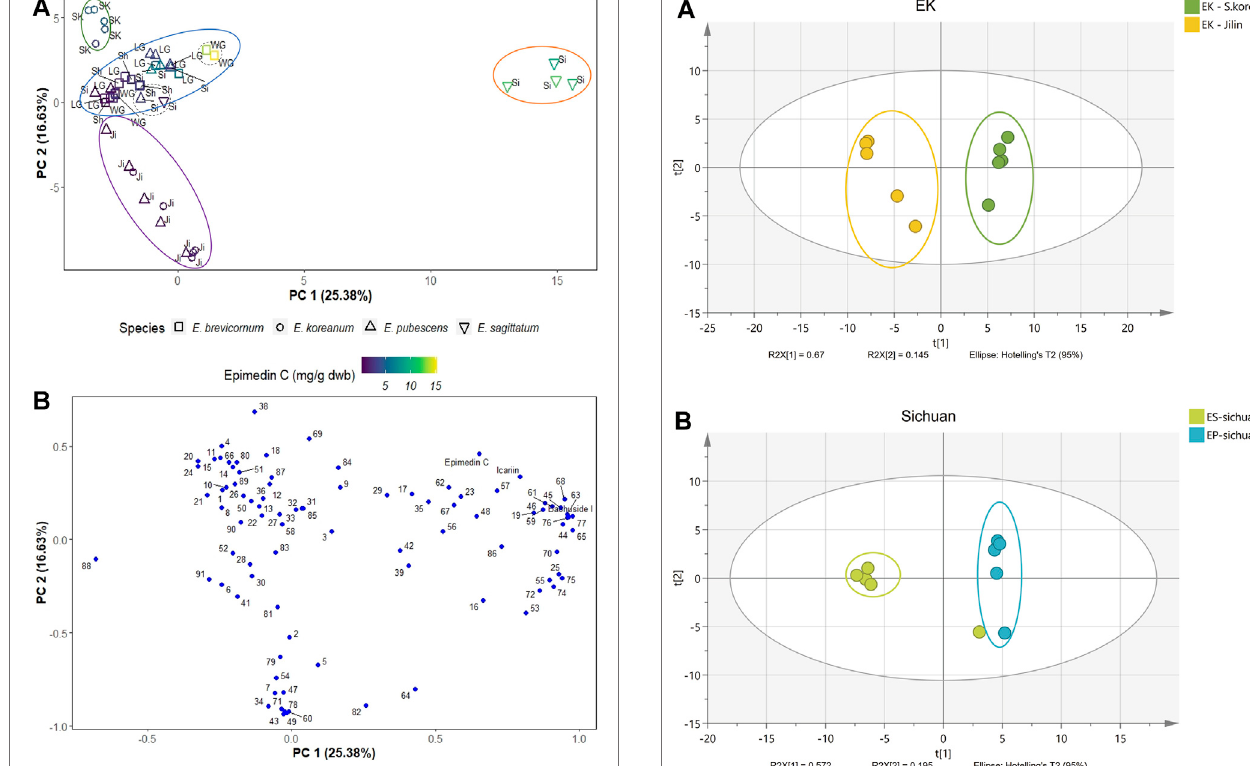
FIGURE 4 | PCA scores plot (A) for same Epimedium species ( E. koreanum , EK) collected in different locations (Daqiu, South Korea and Jilin, China) — A; and PCA scores plot (B) for different species ( E. sagittatum , EK, and E. pubescens , EP) cultivated in the same fi eld (Wanyuan,